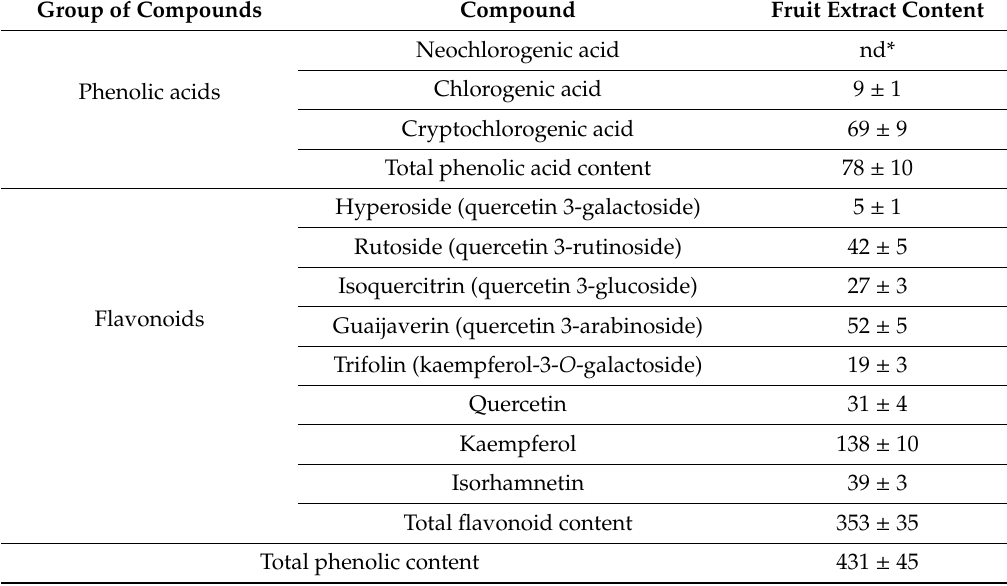
Table 2. The content (mg / 100 g DW ± SD) of main detected phenolic compounds of S. rubriflora fruit extracts ( n = 5, p < 0.05).